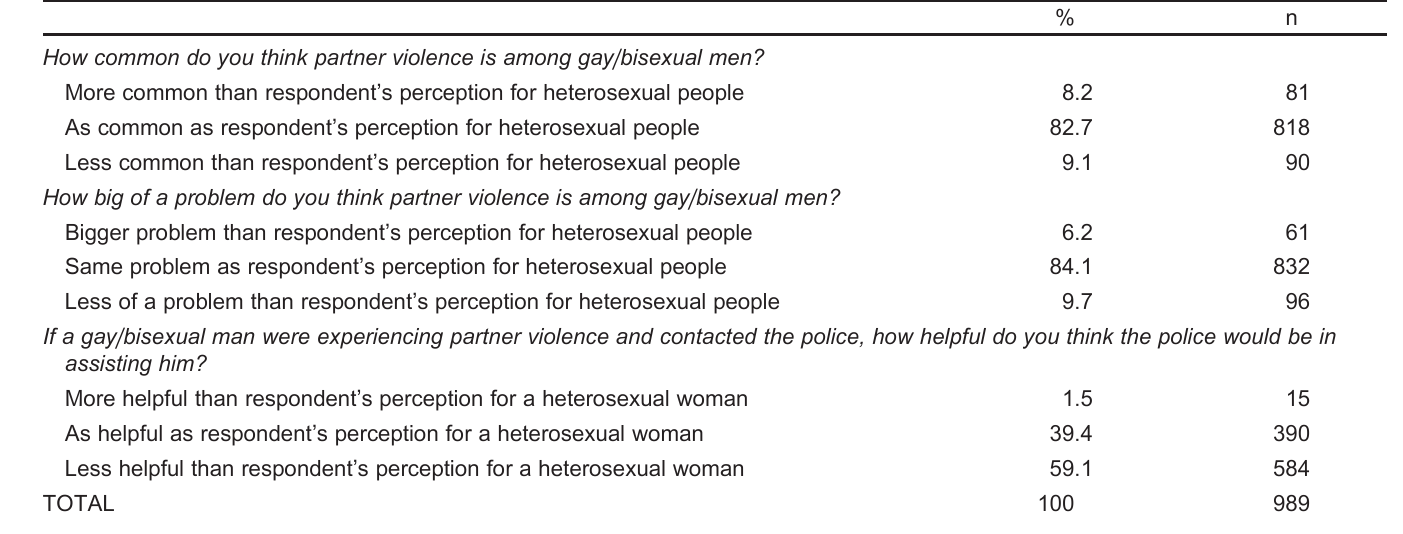
Table 3. Comparative perceptions of commonness of intimate partner violence (IPV), severity of IPV, and police helpfulness in response to IPV for gay/bisexual men versus heterosexual